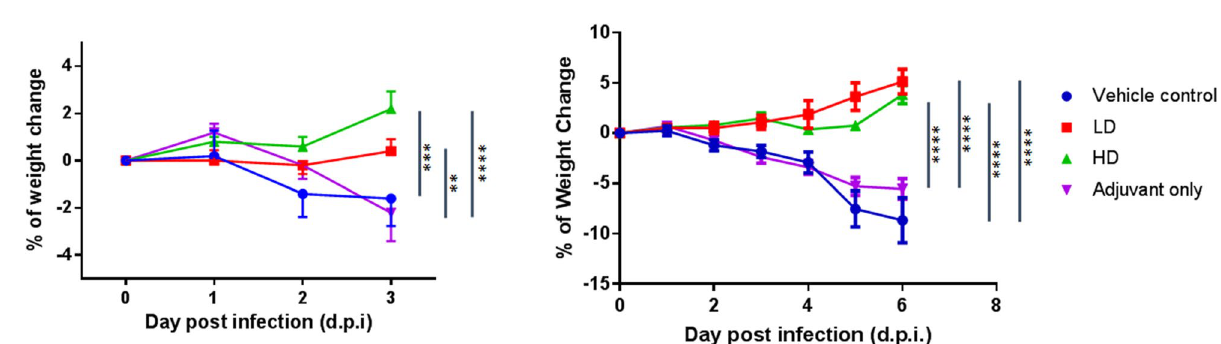
Figure 3. Change in body weight in hamsters after infection with SARS-CoV-2. Hamsters immunized in Fig. 2 were challenged with 10 4 PFU virus. The body weights of individual hamsters were tracked daily up to the time of euthanizing at 3 d.p.i. (n = 5 per group) and 6 d.p.i. (n = 5 per group). Results are presented as mean with error bars representing standard error and statistical significance calculated with Two-way ANOVA with Tukey’s multiple comparison test at 3 d.p.i. (left) or 6 d.p.i.